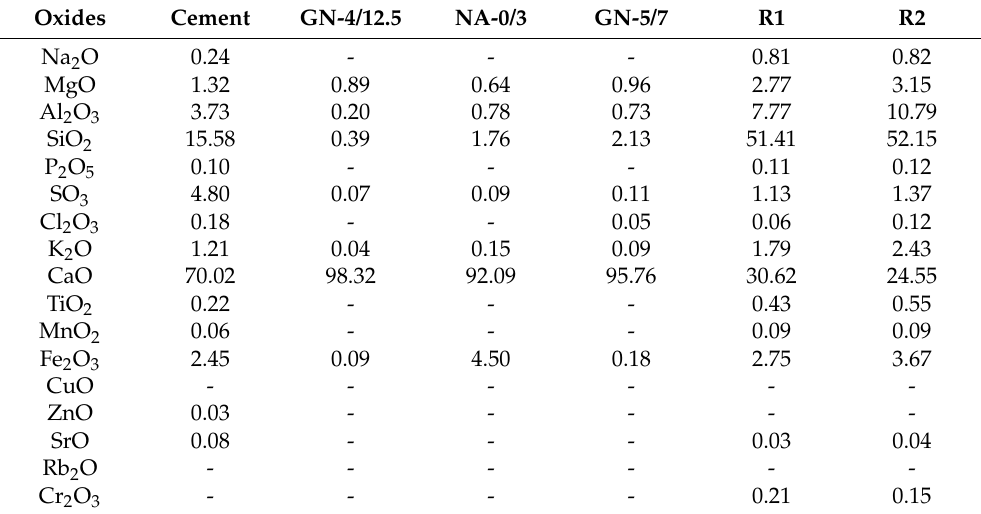
Table 3. X-ray fluorescence (XRF) of the raw